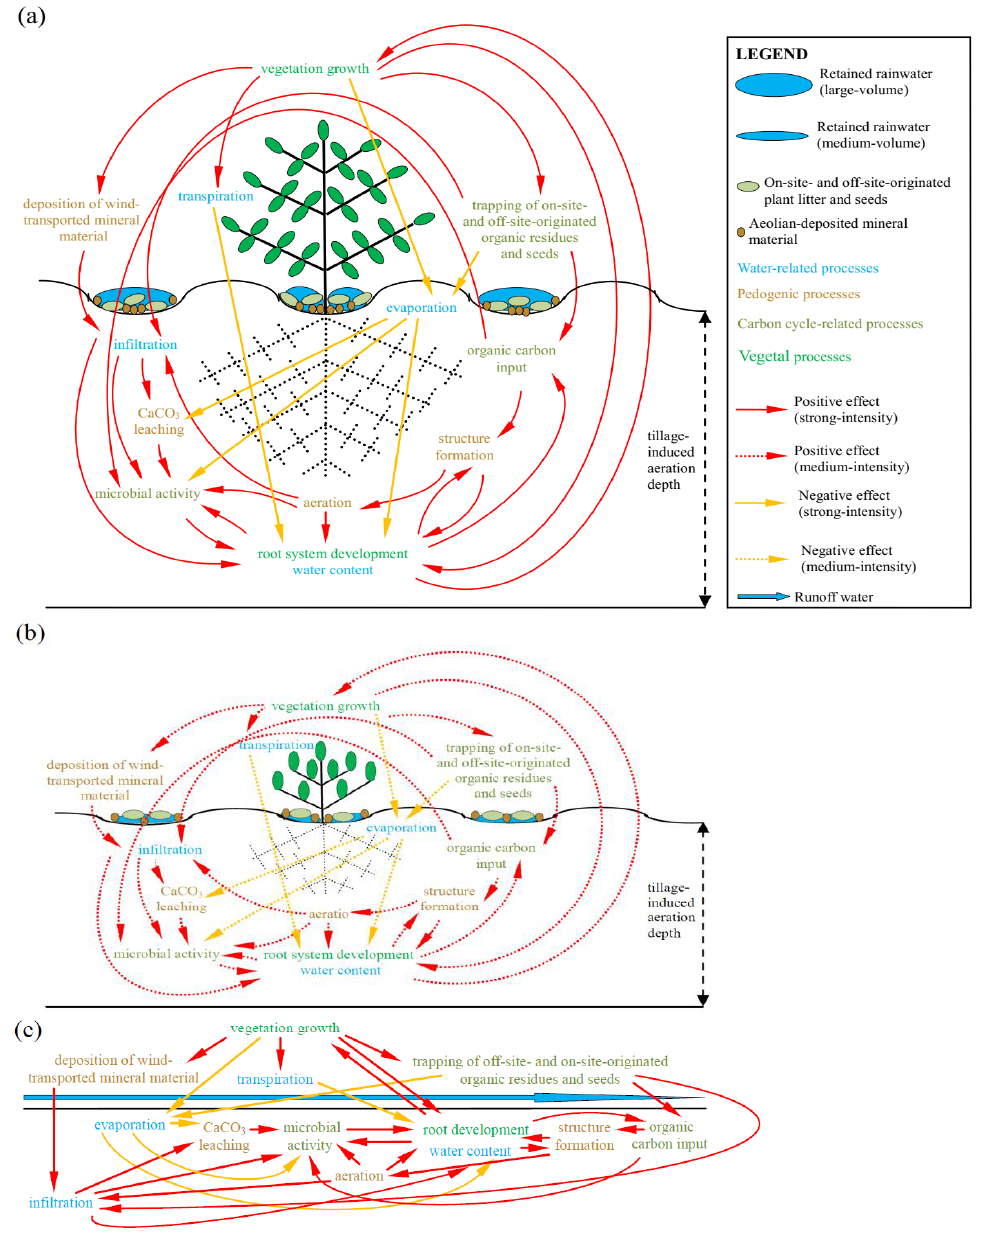
Figure 3. Schematic illustration of feedbacks among water-soil-plant-organic matter under deep chiseling ( a ); shallow chiseling ( b ); and no-tillage ( c ) of severely degraded lands. Deep tillage